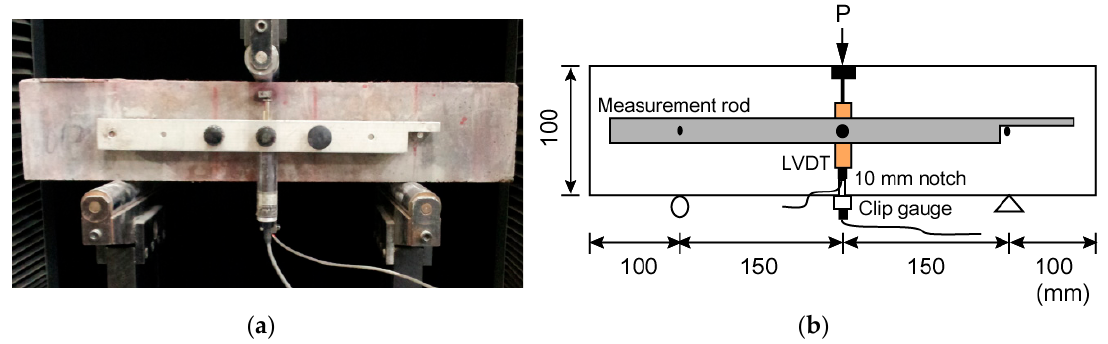
Figure 3. Set-up of three-point bending test with notched beam. ( a ) Test setup; ( b ) Dimensions.